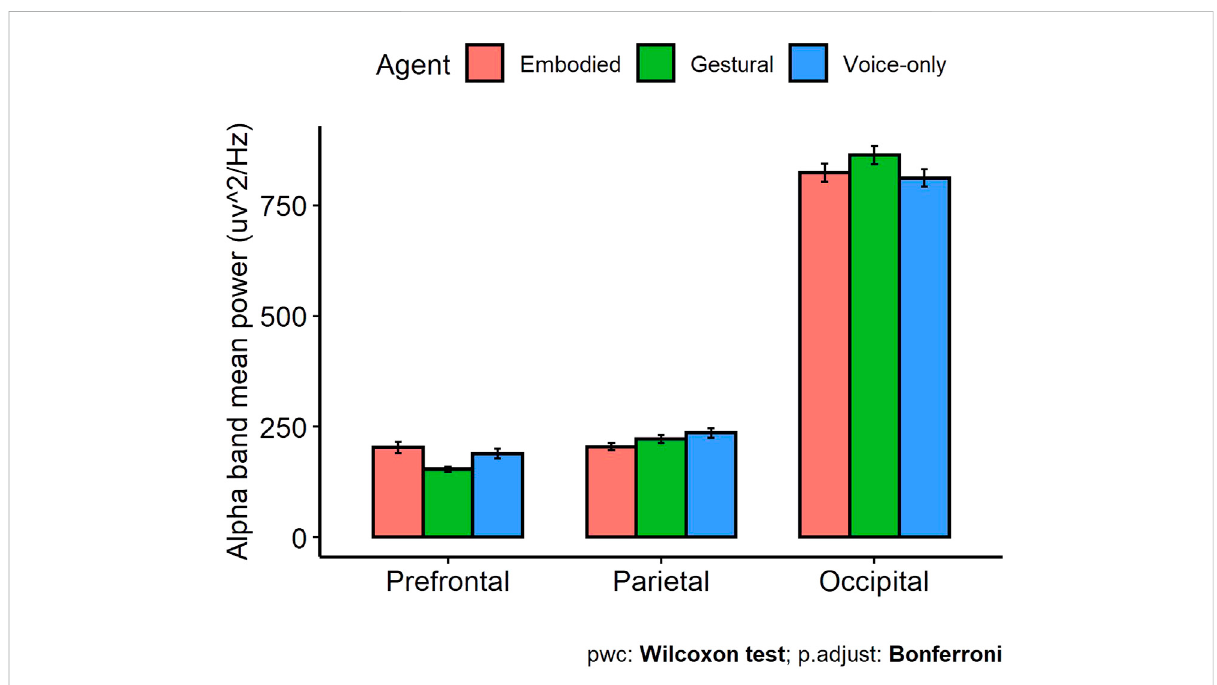
FIGURE 4 EEG alpha band mean power (Error bars represent the standard error of the mean).